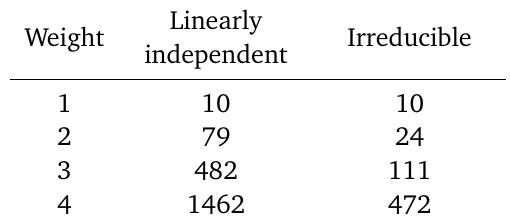
Table 2: Counting of the master integral components at each transcendental weight ( ε order). The second column corresponds to the number of the (cid:81) -linearly indepen- dent components. The third column shows the number of irreducible components, i.e. the number of pentagon functions. Linearly Weight Irreducible independent 1 10 10 2 79 24 3 482 111 4 1462